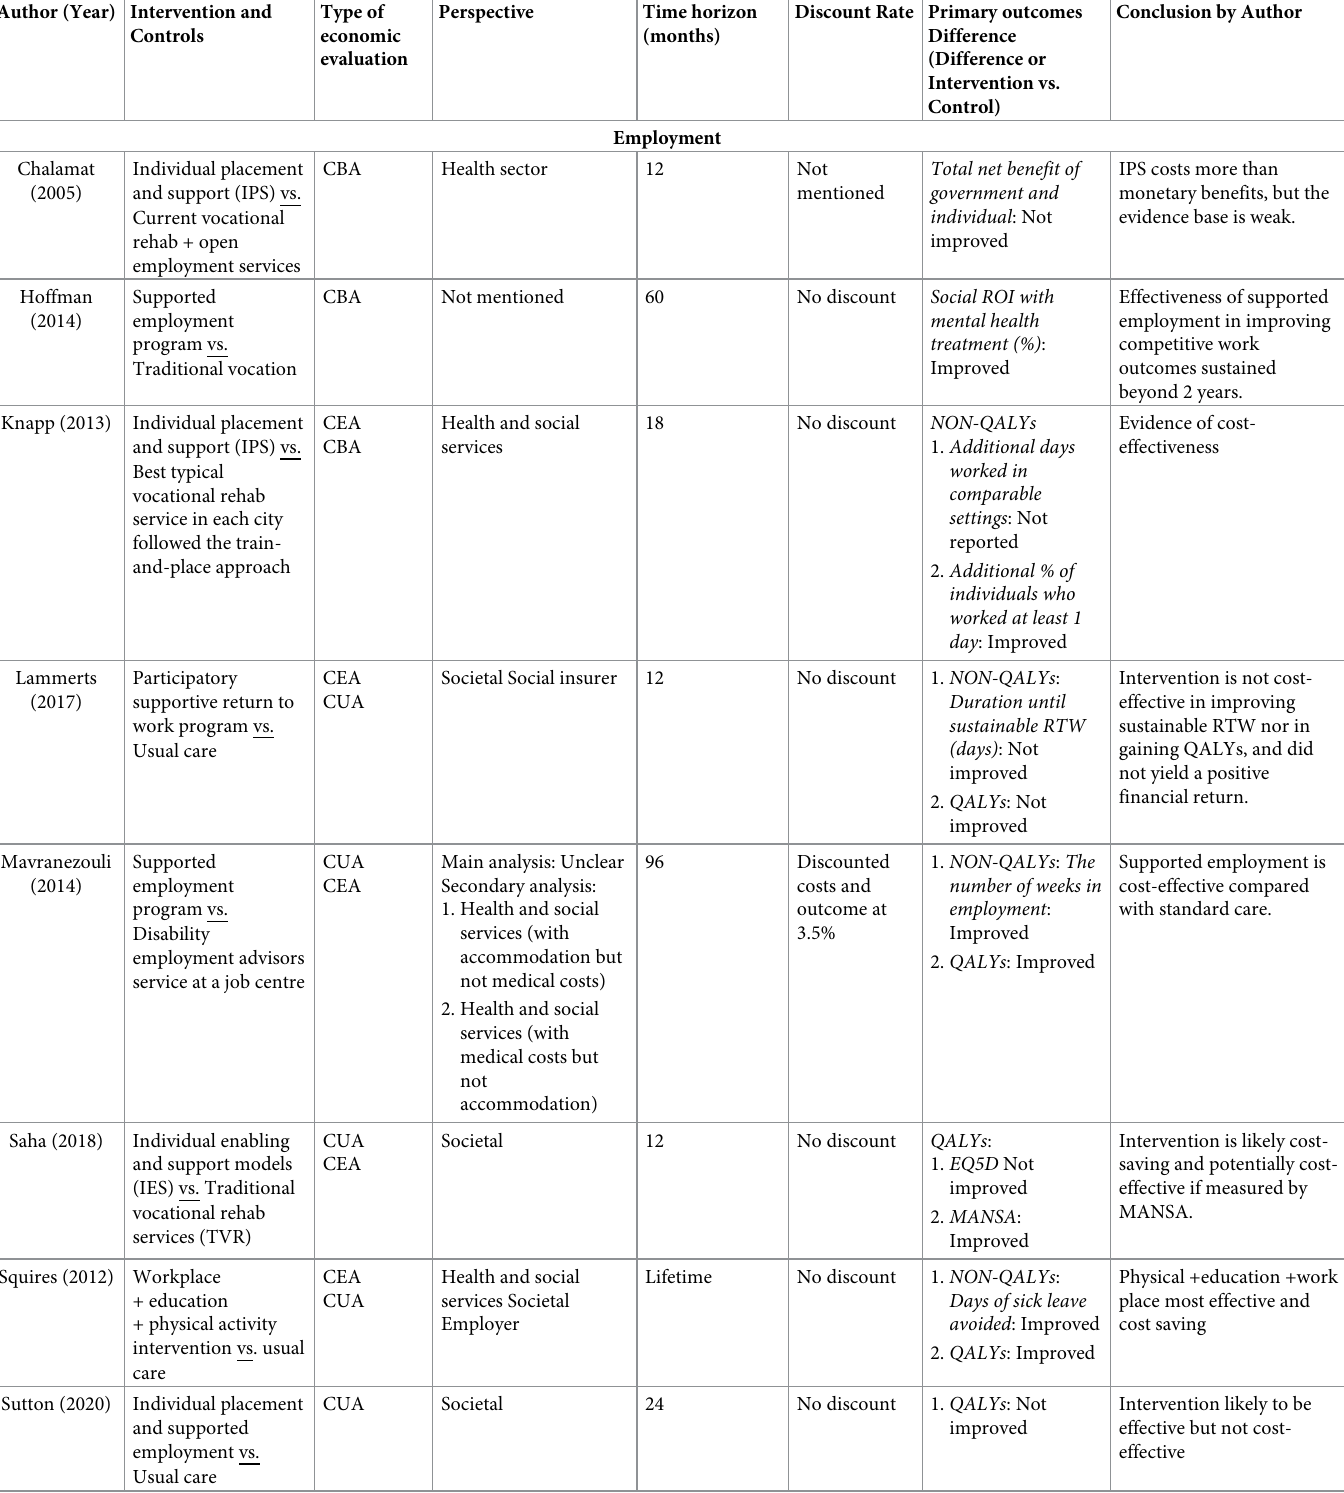
Table 1. Summary of the key characteristics of the included